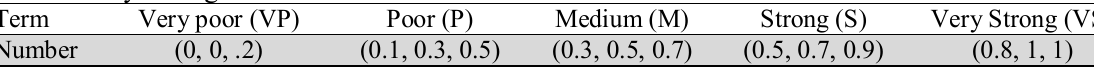
The summary of linguistic verbs